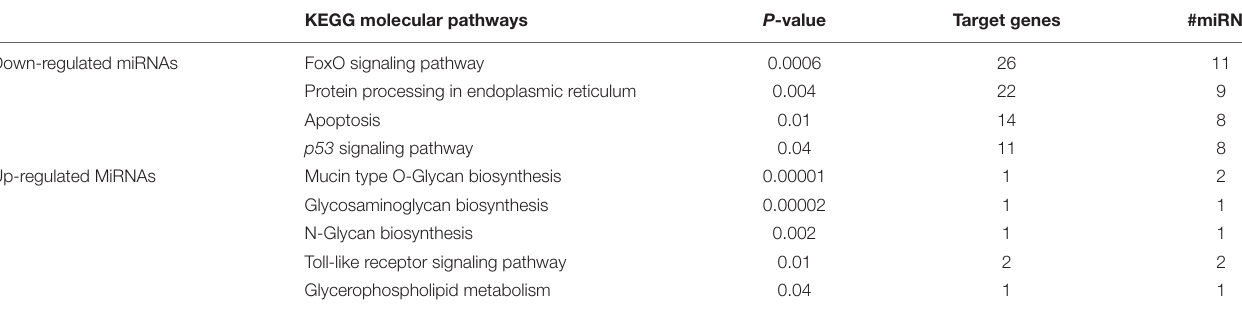
TABLE 3 | KEGG molecular pathways differentially expressed miRNA-targeted genes in sperm cells of gh -transgenic and non-transgenic zebrafish. KEGG molecular pathways P -value Target